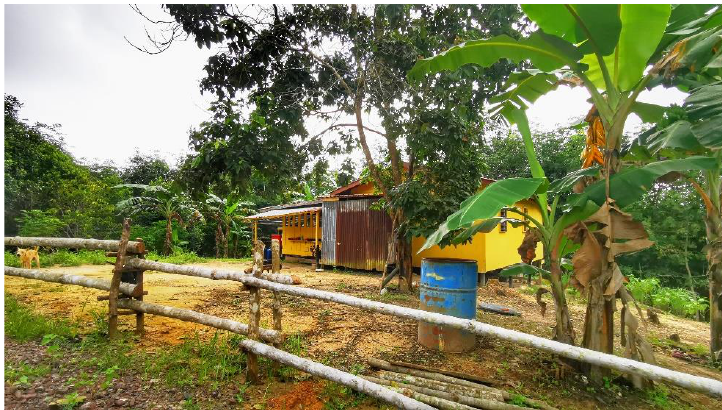
Figure 8. A local villager ’ s house surrounded by forest, plantation and fruit trees. “Ten years ago, there were fewer monkeys here. Human activities might be why the monkeys and mosquitoes are g etting closer to humans…trees were cut down... there are less forest areas now…[paused]. In our village, we are surrounded by oil palms, rubber trees, coconut trees... banana….and monkeys... there are everywhere! [They are] destroy- ing the fruit trees, crop s and plantations…[CL08] 3.5. Socioeconomic Factors Socioeconomic factors such as daily occupational-related activities and housing structures are related to exposure to mosquito bites and make it challenging to control malaria in the village. Activities such as farming, fishing, collecting forest plants, vegeta- bles, and honey, and forest-related work increase the risk of mosquito exposure. The ma- jority of the villagers work as farmers, rubber tappers, and oil palm workers. During these activities, the gatekeepers expressed that practices to avoid mosquito bites were not suffi- ciently performed due to several individual reasons. Poverty and the inability to purchase mosquito repellent, for example, increase the risk of mosquito bites as these occupational